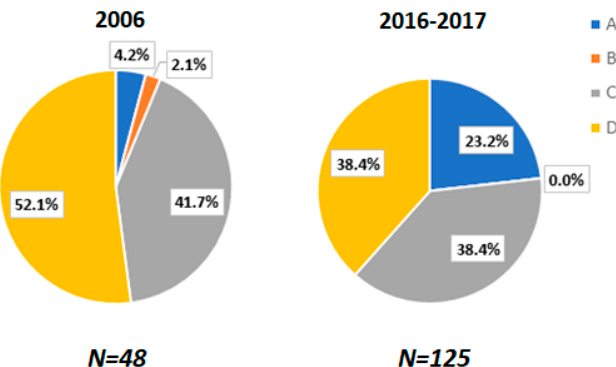
Figure 7. Relative proportions of HBV genotypes in isolates tested in 2006 and 2016–2017.